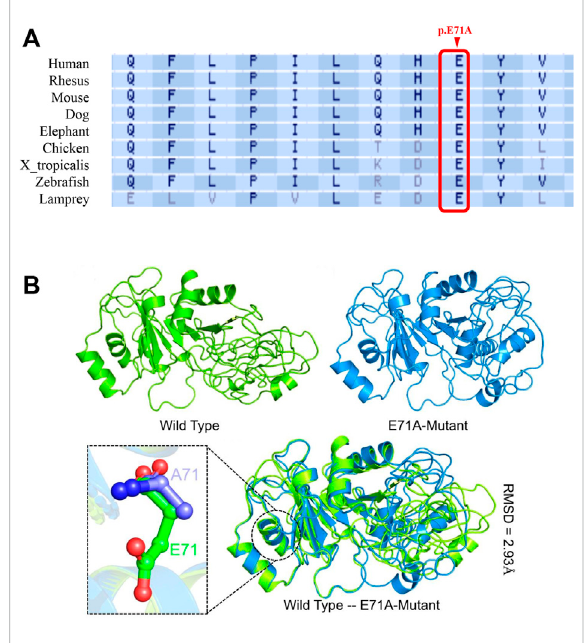
FIGURE 2 DND1 E71 is highly conserved, and the E71A mutation is likely to be pathogenic. (A) Multiple protein sequence alignment shows that the affected amino acid across species was highly conserved. Arrowheads, the mutation site. (B) The predicted structure of the DND1 protein. The wild type structure is shown in green while the E71A mutant is given in marine blue. The mutated residue is also shown as stick in the lower panel. As predicted, the E71 is exposed to the surface of the α -subunit and E71A the mutant may reduce protein